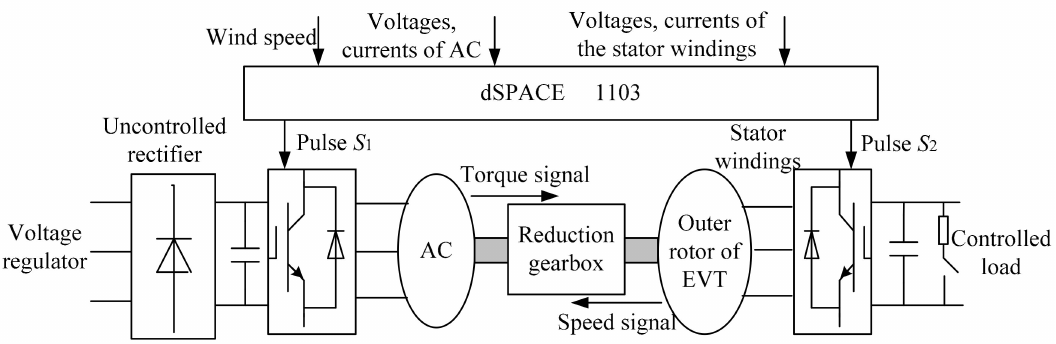
Figure 9. Experimental control platform for testing the sensorless MPPT